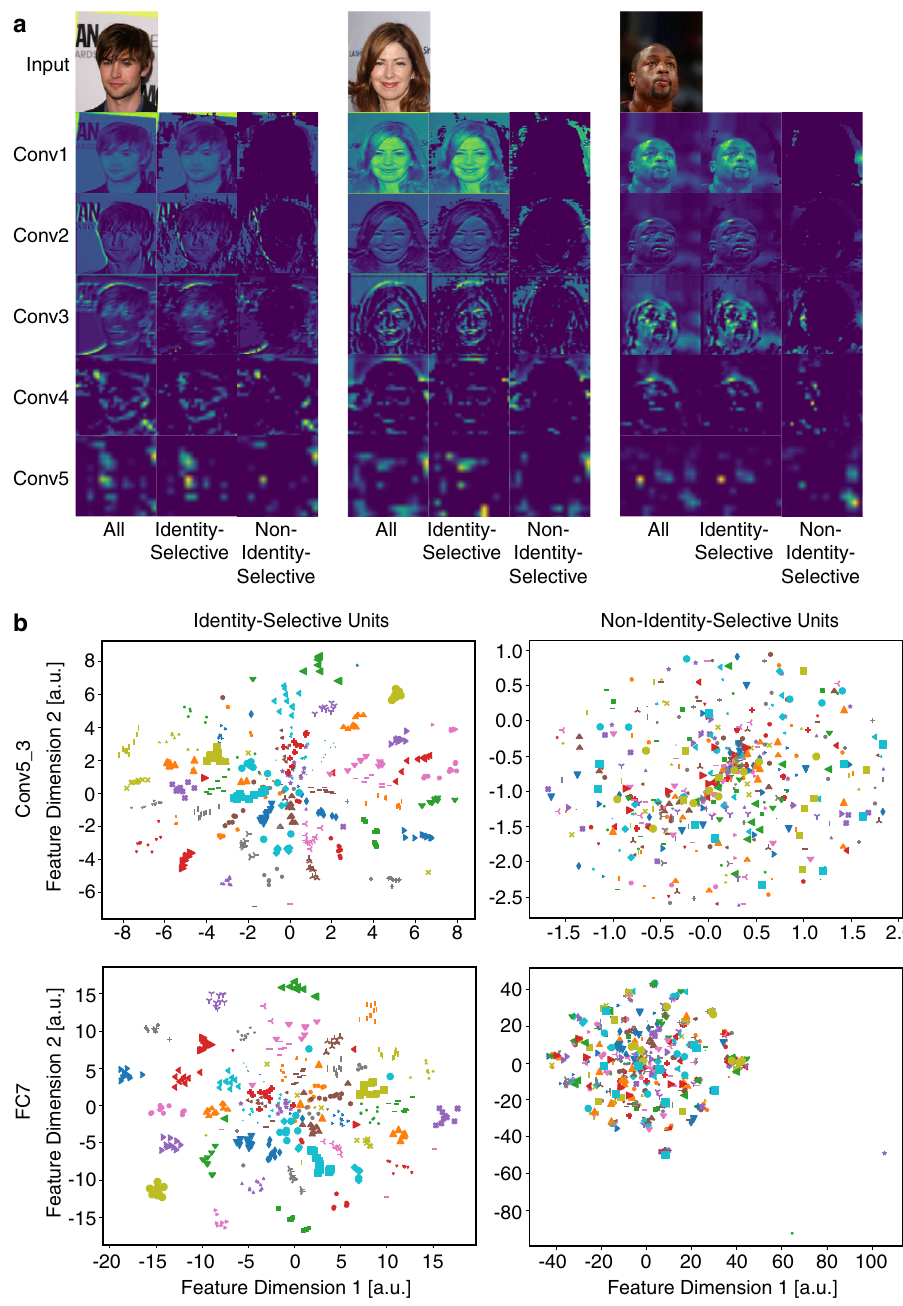
Fig. 3 Visualization of the deep neural network (DNN). a Example activation maps for a subset of DNN layers. Left: all units. Middle: identity-selective units. Right: non-identity-selective units. b Visualization in the t-SNE space for DNN layers Conv5_3 (upper row) and FC7 (lower row). Each color-shape combination represents a face identity (ten faces per identity). The feature dimensions are in arbitrary units (a.u.). Left column: identity-selective units. Right column: non-identity-selective